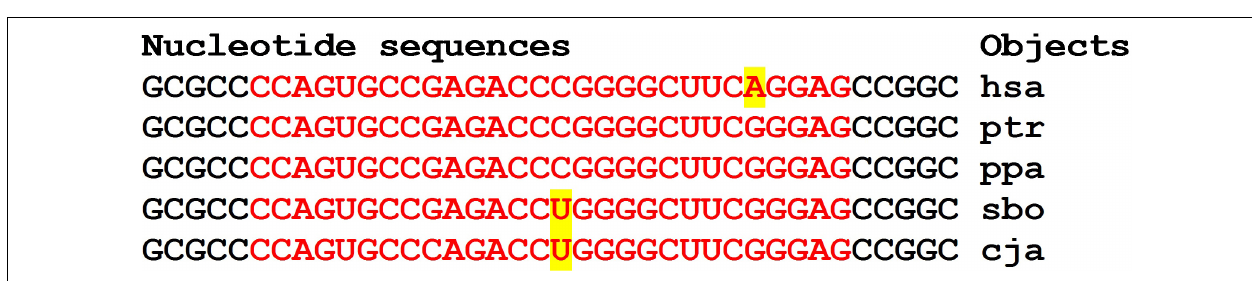
FIGURE 6 | Nucleotide sequences of 5 (cid:48) UTR regions of mRNAs of orthologous CCNY genes containing clusters of miRNAs binding sites.